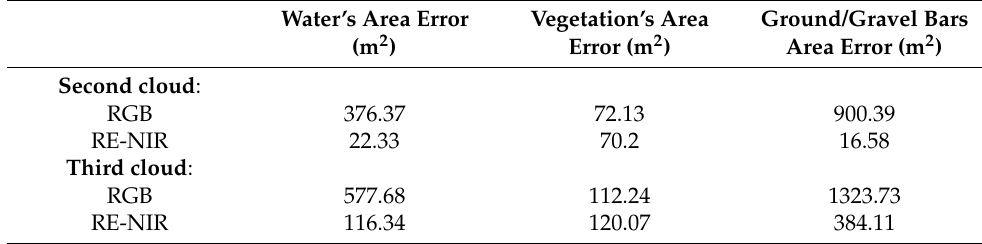
Table 8. Overview about square meters errors for every classes: RGB and RE+NIR